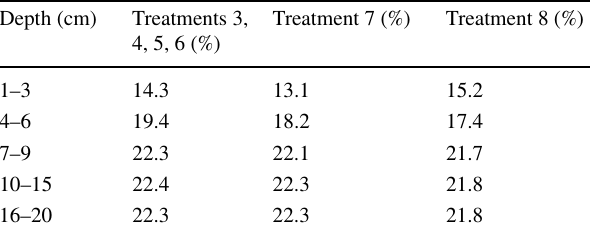
Table 2 Initial soil moisture content for multiple rainfall